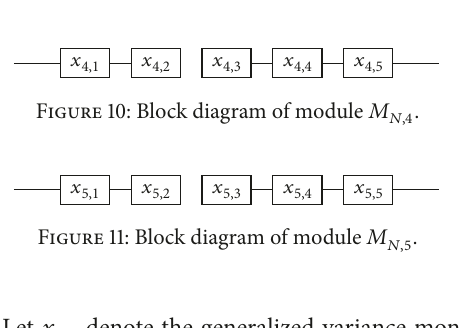
Figure9:Improvedblockdiagramofmodule 𝑀 𝑁,3 .Thecomponent 𝑥 3,4 is replaced by a parallel structure function